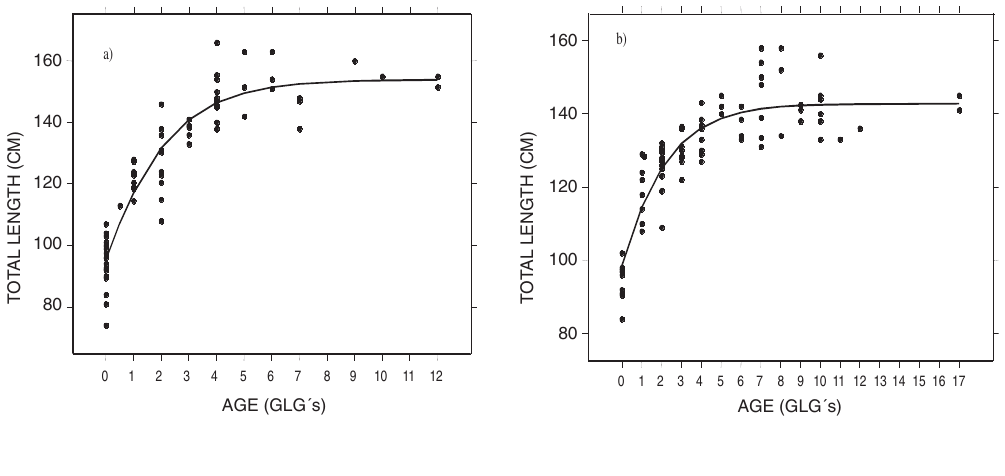
Fig. 5. Length at age curve for female porpoises (n=85) (a), and male porpoises (n=91) (b), from 3 regions of West Greenland (1988, 1989 and 1995) with fitted Gompertz growth